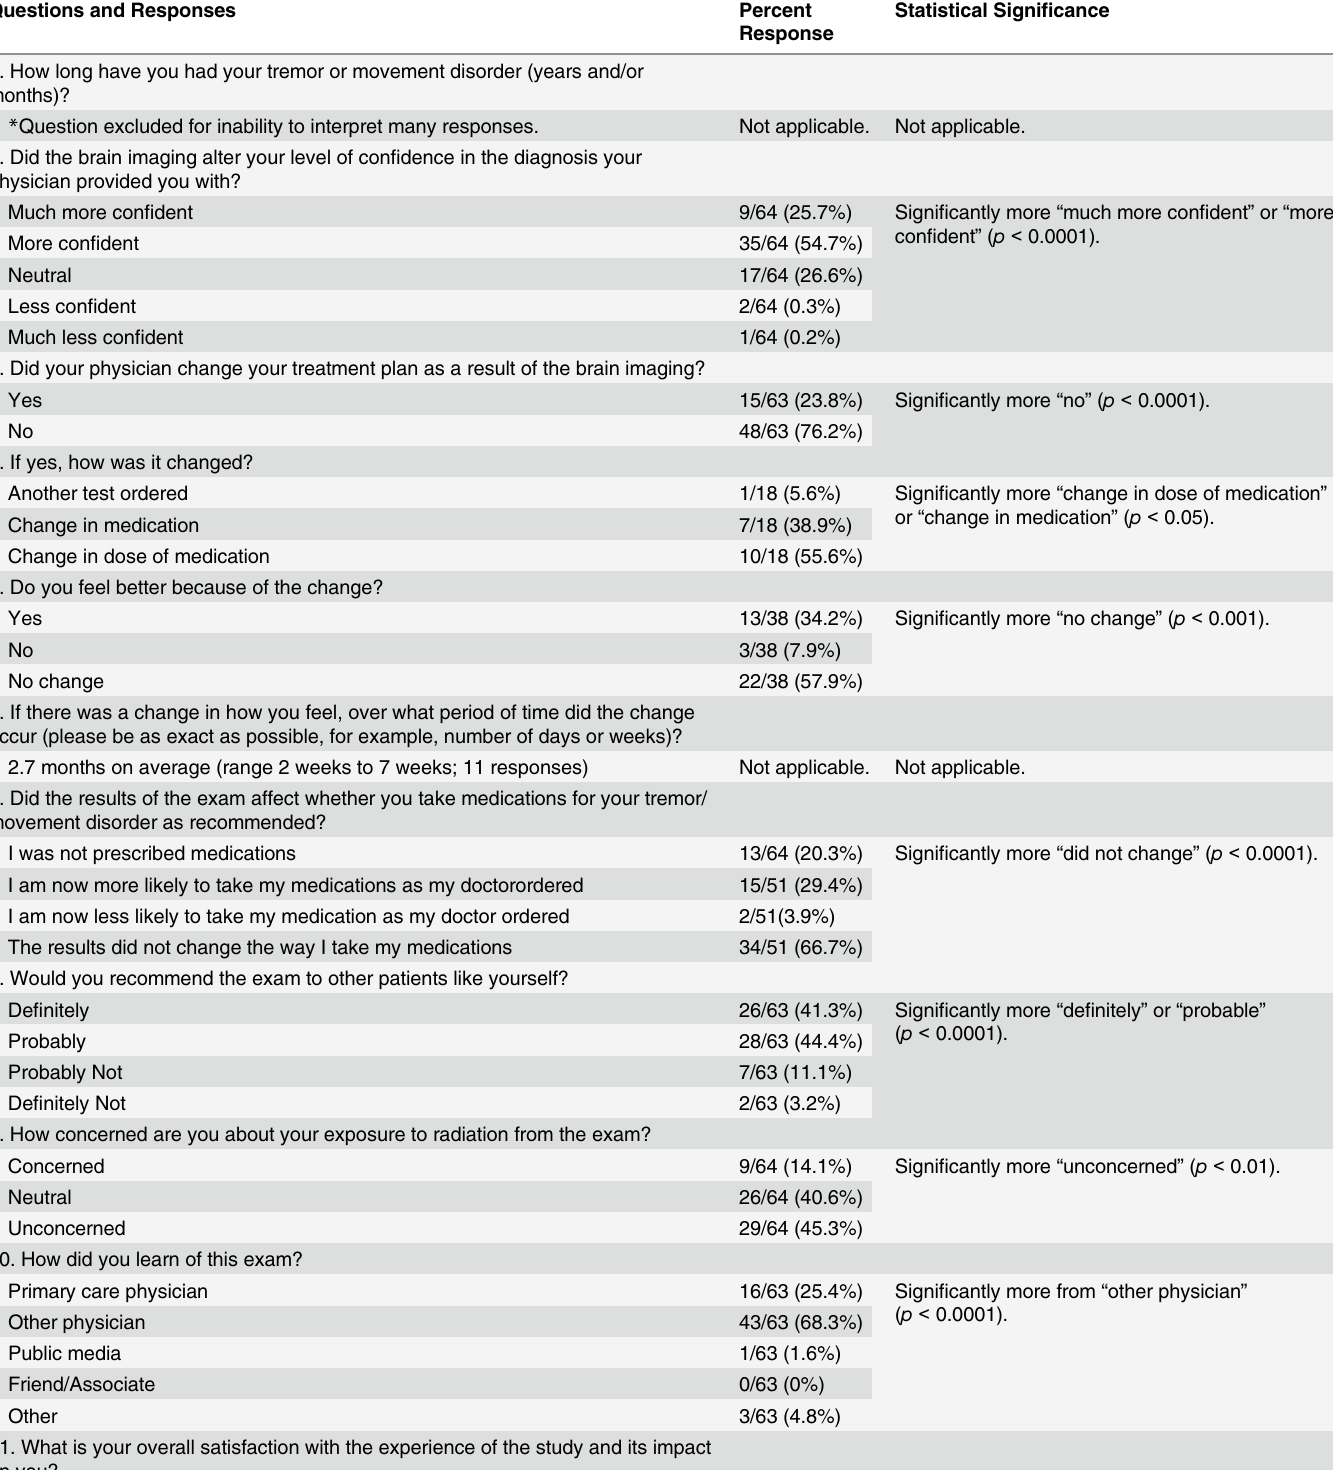
Table 1. Patient survey questions and